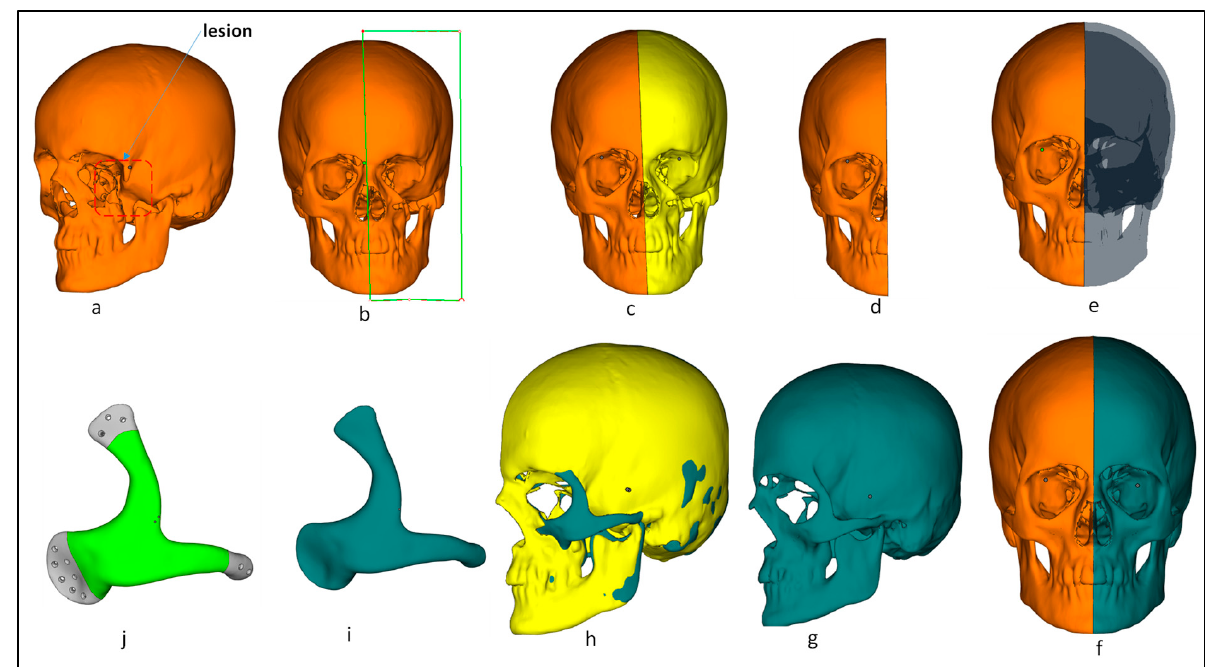
Figure 3. Step-by-step process from the patient with lesion to the finally obtained customized facial implant: ( a ) patient with left lesion; ( b ) midplane selection for resection of facial bone; ( c ) facial bone after resection; ( d ) removal of left-side tumor region; ( e ) mirroring the healthy right side of facial bone; ( f ) obtaining the healthy mirrored right-side region; ( g ) healthy mirrored right-side region; ( h ) performing Boolean operation between the left tumor region (yellow) and obtained mirror right region (teal green); ( i ) customized facial implant after the Boolean operation; ( j ) tapered screw-holes introduction for smoother fixation.